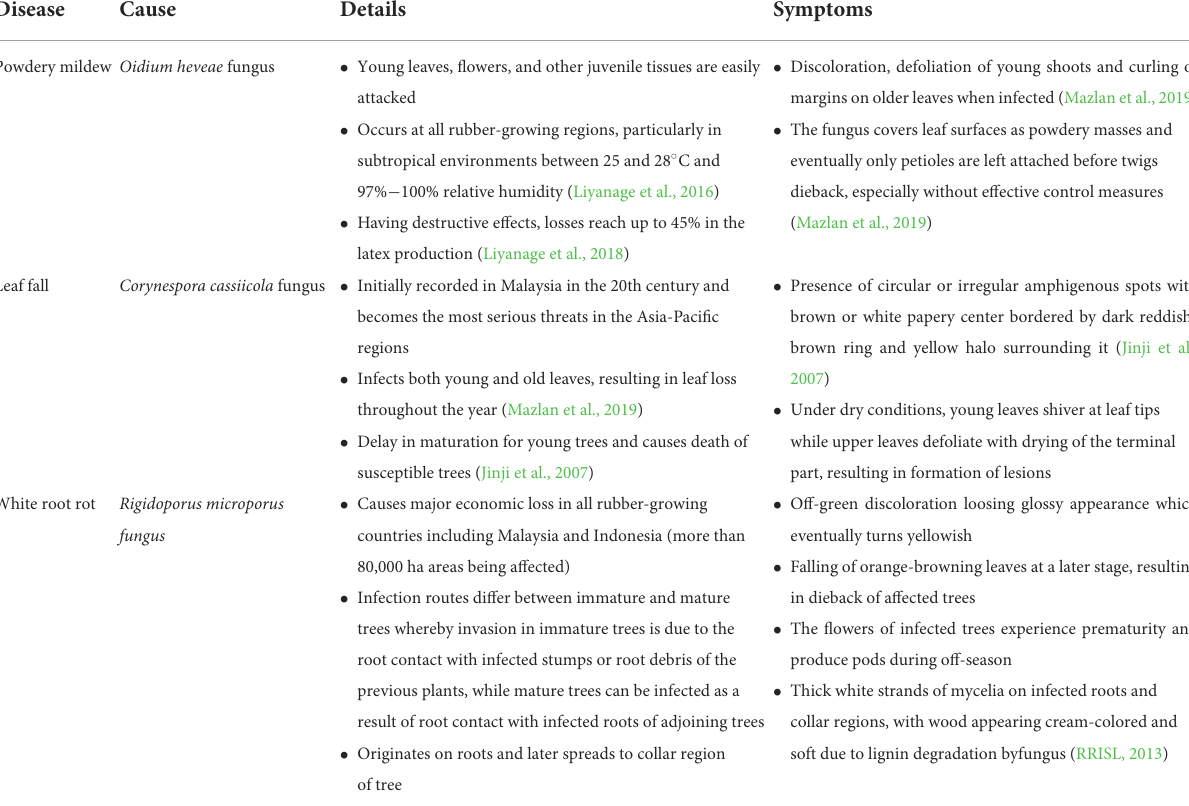
TABLE 2 A summary of major diseases affecting rubber